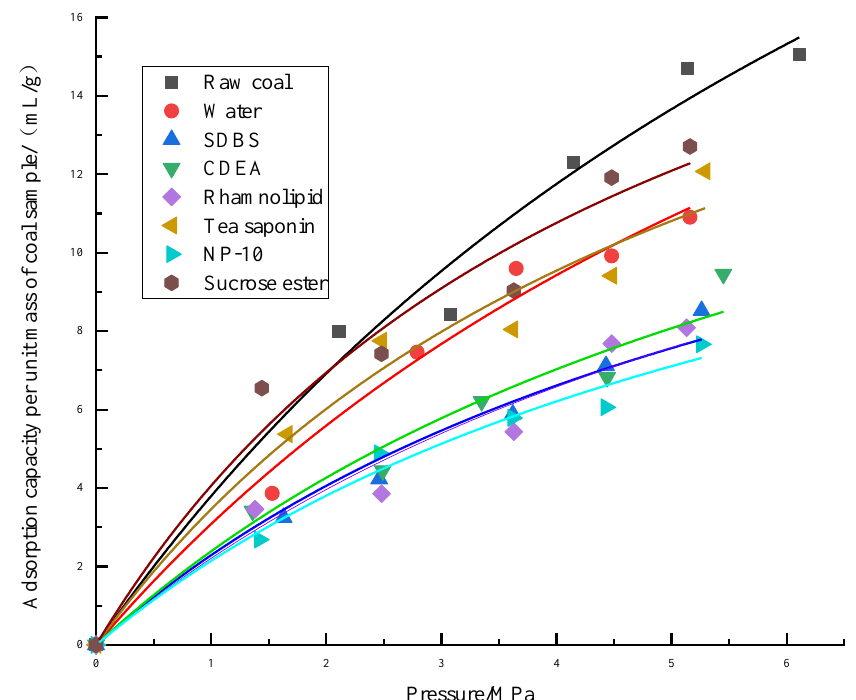
Figure 7. Experimental results and fitting curve of nuclear magnetic adsorption of gas. Table 7. Fitting results of gas nuclear magnetic adsorption experiment.